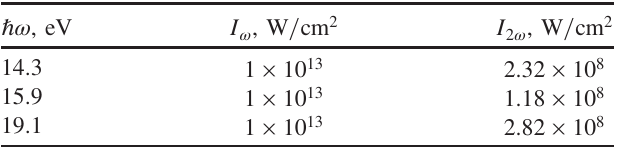
TABLE II. Parameters used for theoretical calculations. I ω and I 2 ω are the peak intensities of the fundamental and second harmonic,